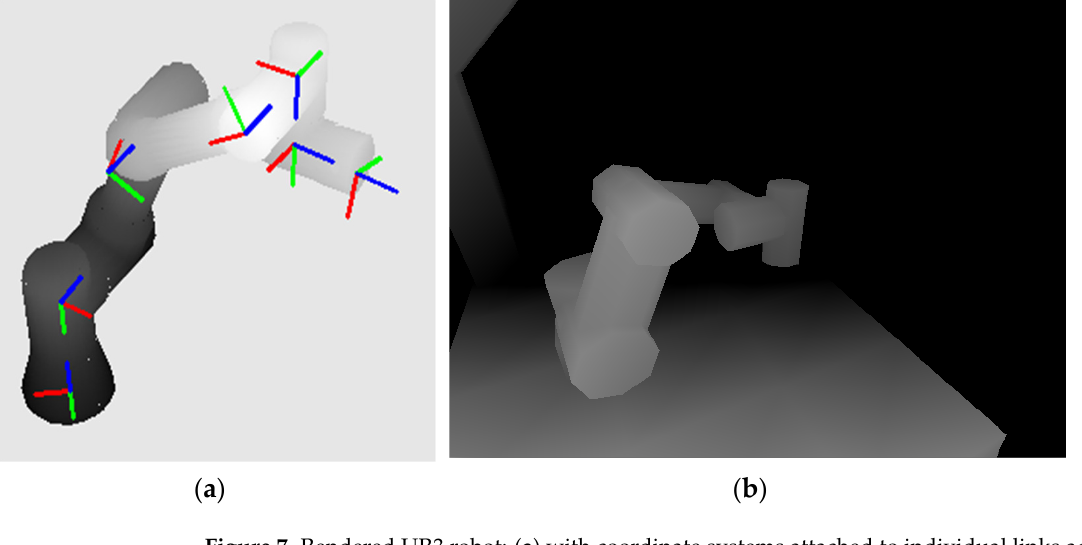
Figure 7. Rendered UR3 robot: ( a ) with coordinate systems attached to individual links according to the Denavit–Hartenberg principle (the blue z- axes represent the axes of rotation); ( b ) reconstructed expected depth map of the workspace.